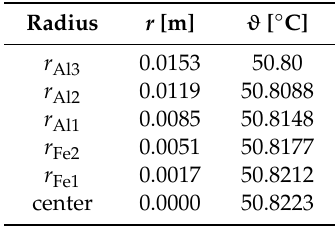
Table 1. Temperature in dependence of radius.